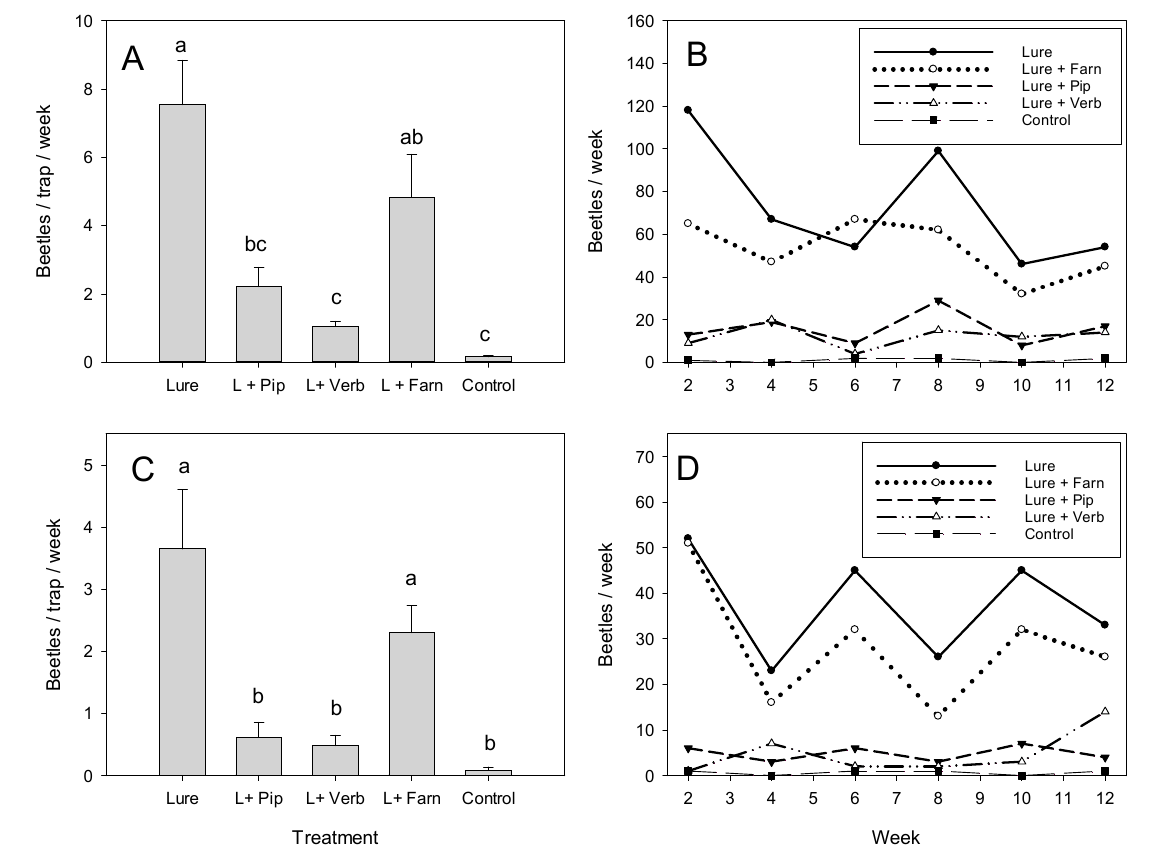
Figure 4. Captures of female Euwallacea perbrevis in replicate 12-week field tests comparing repellents deployed in 2 commercial avocado groves, Miami-Dade County, FL, USA. ( A ) Mean (±SE) captures and ( B ) summed weekly captures in field test 4, and ( C ) mean (±SE) captures and ( D ) summed weekly captures in field test 5. Treatments consisted of sticky panel traps baited with a combination lure (quercivorol and α -copaene), traps baited with a combination lure plus piperitone, traps baited with a combination lure plus verbenone, traps baited with a combination lure plus α -farnesene, and non-baited control traps. Bars topped with the same letter are not significantly different (Tukey’s HSD mean separation, p < 0.05).